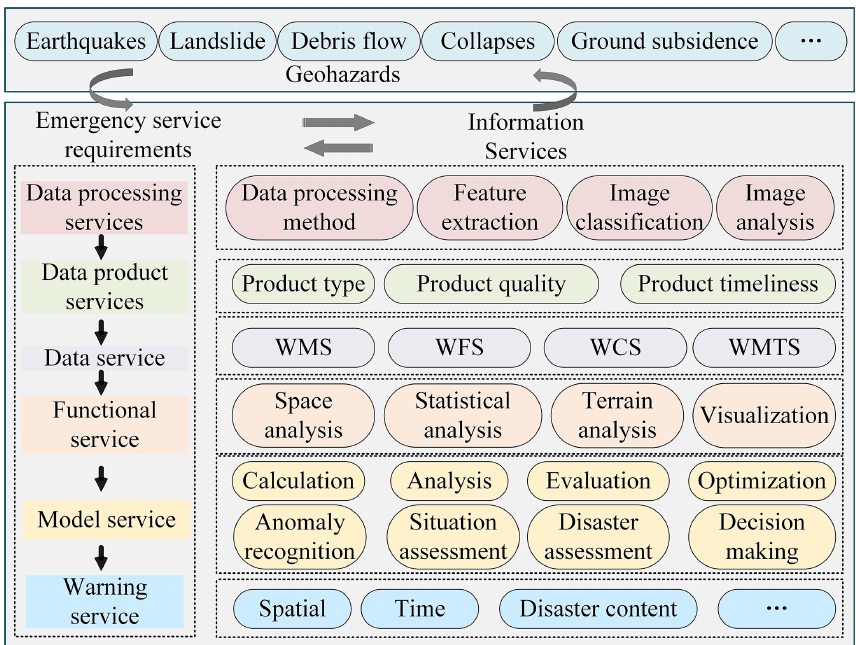
Figure 2. Emergency geographic information